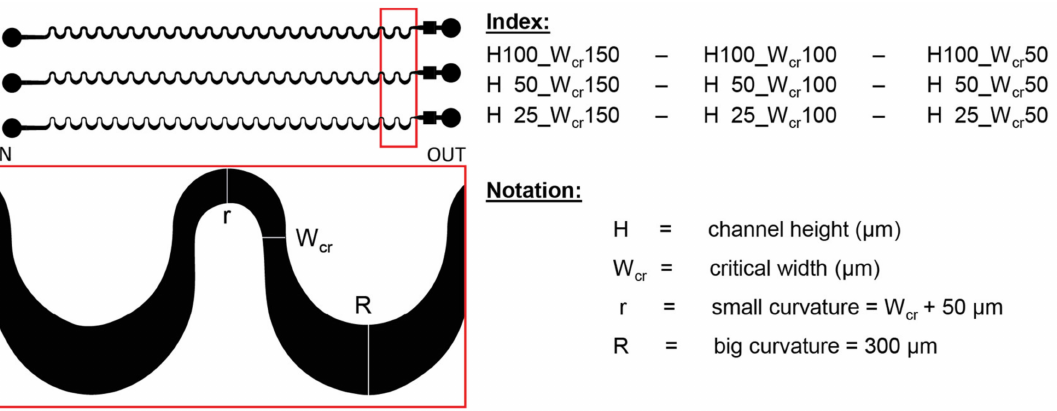
Figure 2. The schematic design of the lithographic mask representing the obtained geometrical parameters. Red box indicates the magnified area of the mask